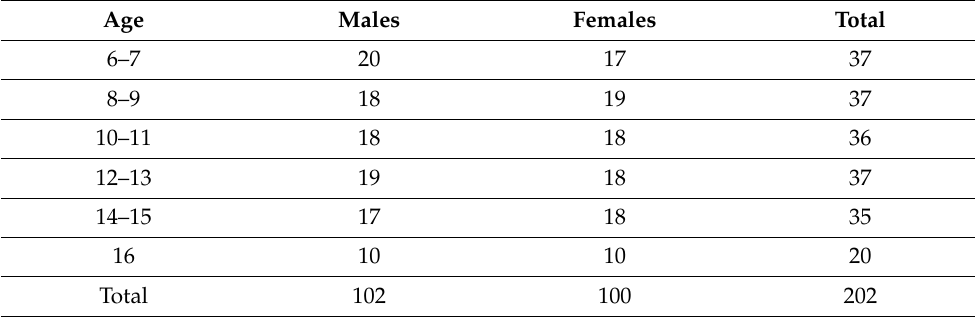
Table 1. Distribution of the sample according to sex and